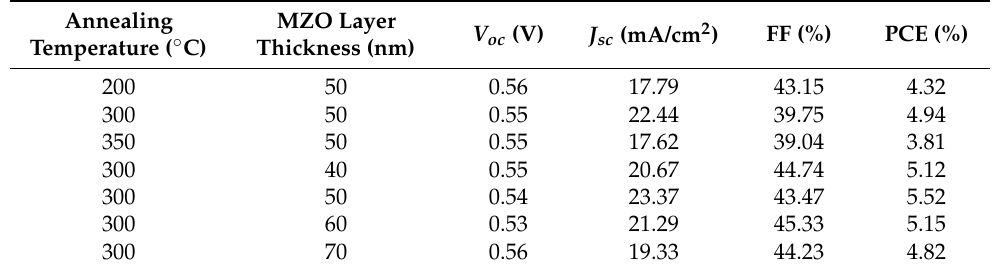
Figure 3. J - V characteristics of ITO/Mg-doped ZnO (MZO)/PbS CQDs/Au devices with ( a ) different annealing tempera- tures and ( b ) MZO thicknesses. Table 1. Summarized photovoltaic parameters from J-V curves (Figure 3a,b) of PbS CQD solar cells prepared under different